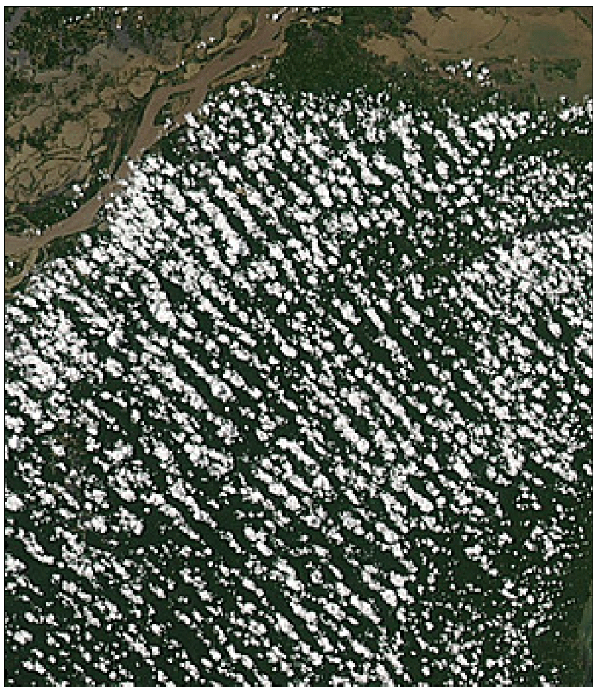
Figure 2. Magnified view of forest cumulus (FCu) cloud fields (sub- set of Fig. 1). Note the linear patterns in which the FCu organize. The scale of the box is 150km ×